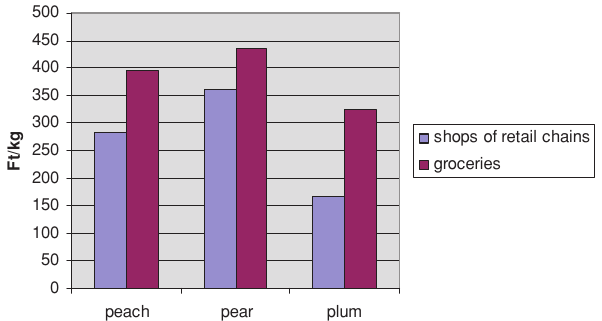
Figure 3. Average prices of peach, pear and plum sold in department stores and in small